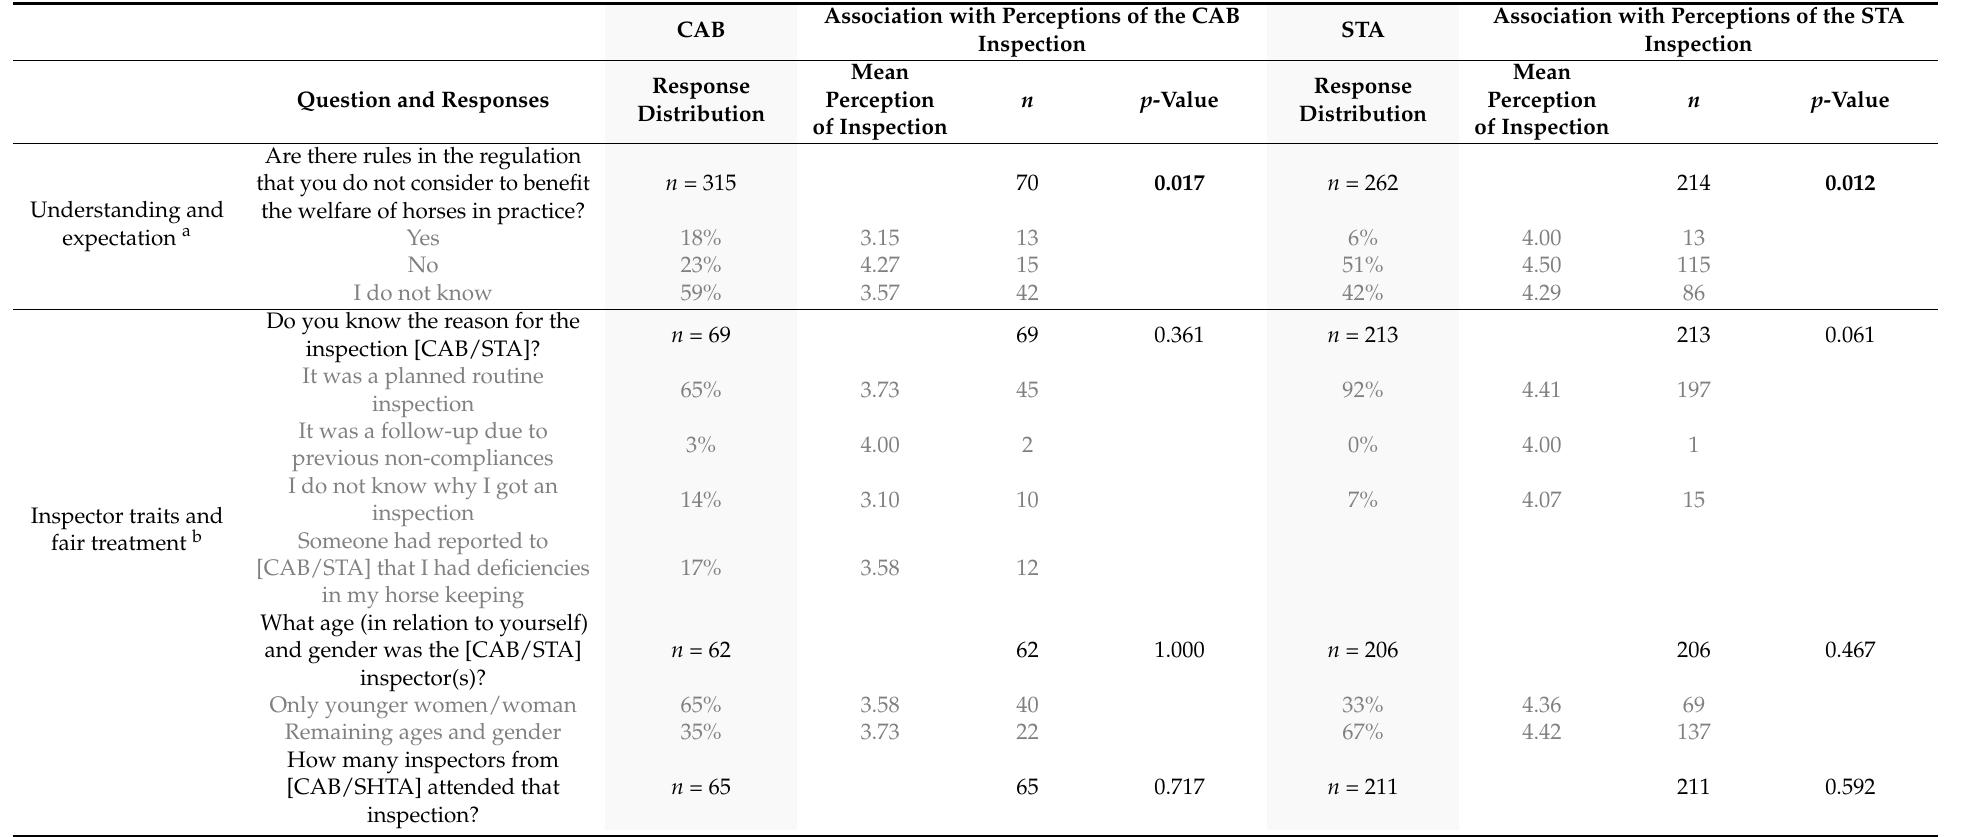
Table 3. Results of association tests (Fisher’s exact test) between categorical questions and perceptions of County Administrative Board (CAB) and Swedish Trotting Association (STA) inspections. For each question, each response is shown for CAB and